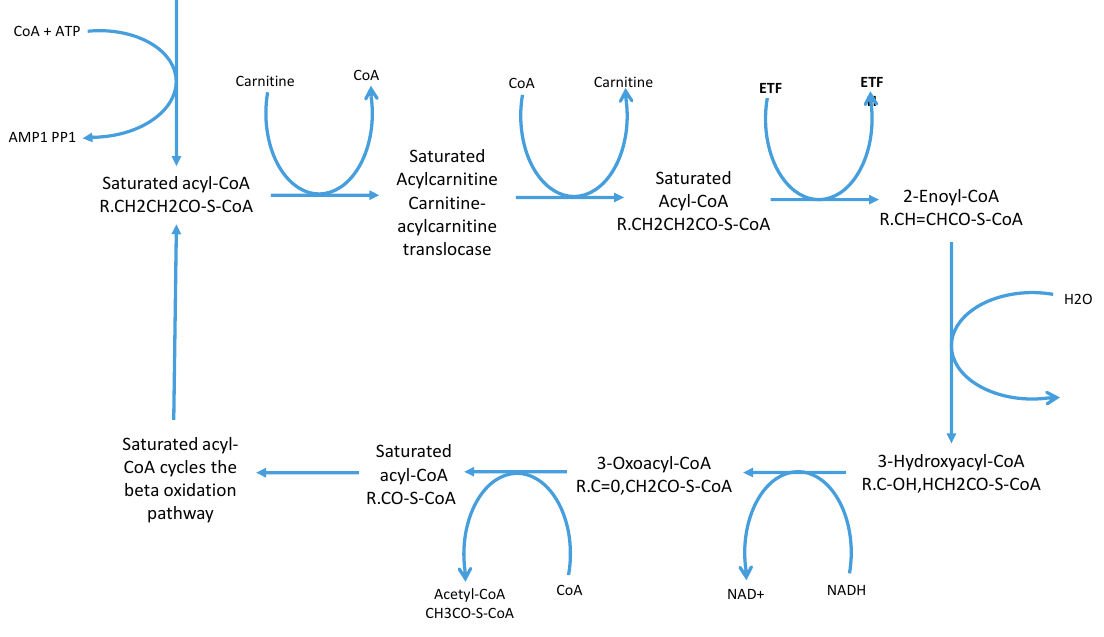
Figure 2. Cyclic β -oxidation process and the production of the acetyl CoA molecules [76]. This diagram shows the substrates and products of each reaction in the β -oxidation